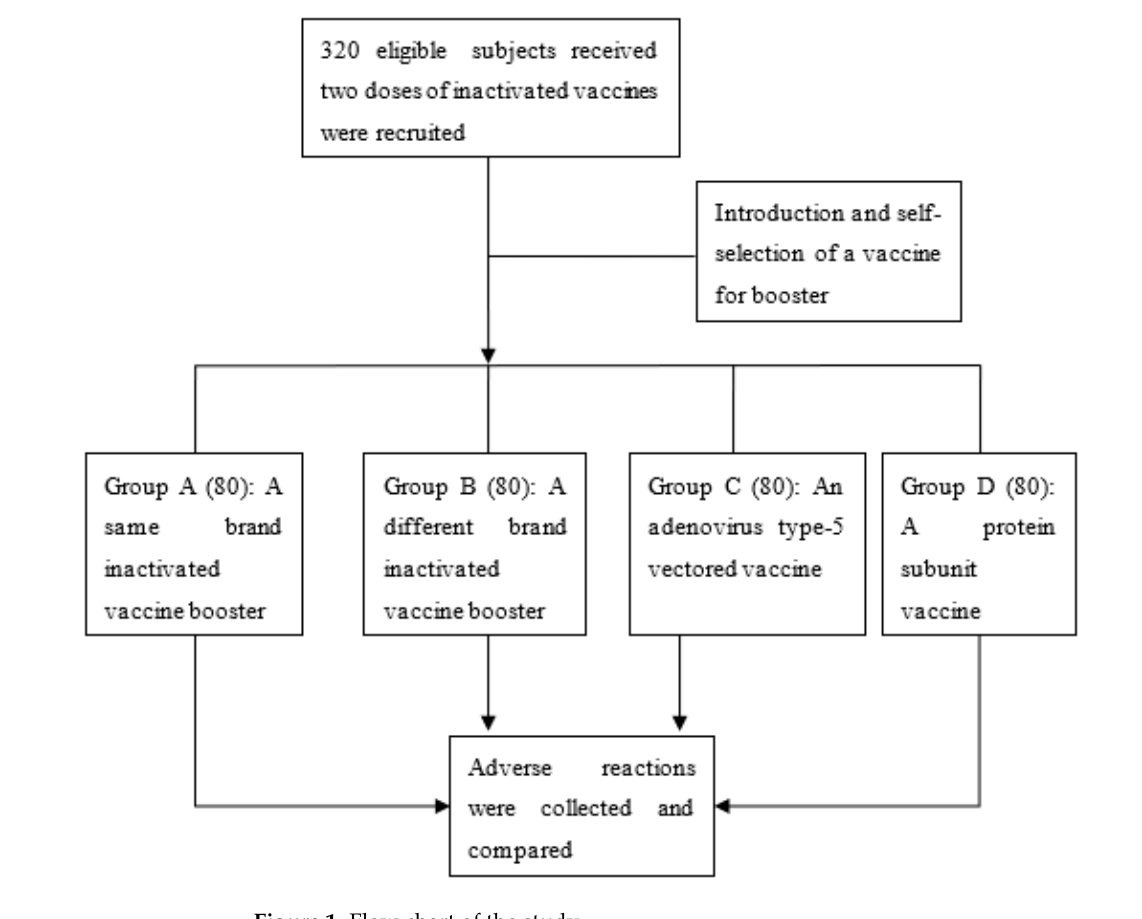
Figure 1. Flow chart of the study. Table 1. Basic characteristics and adverse reactions after a vaccine